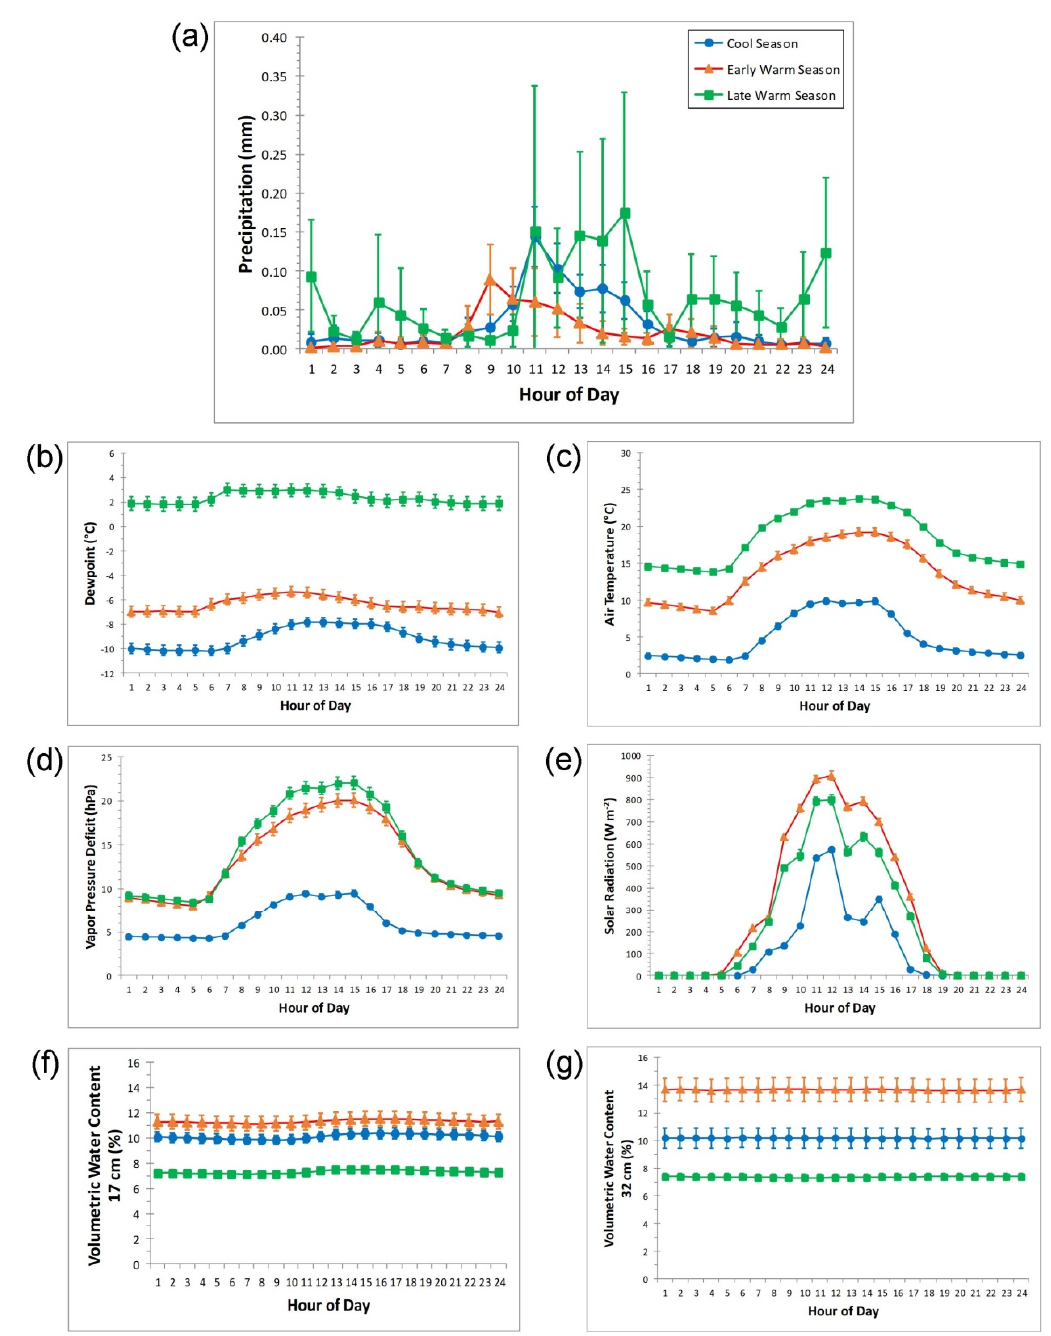
Figure 4. Average diurnal cycles of weather and soil variables by season. The variability of each hourly value is shown by vertical bars corresponding to two standard errors above and below the mean. Meteorological variables include: ( a ) total precipitation, ( b ) dewpoint temperature, ( c ) air temperature, ( d ) vapor-pressure deficit, ( e ) and solar radiation. Soil variables are ( f ) volumetric water content (VWC) at 2–17 cm soil depth, and ( g ) VWC at 17–32 cm soil depth.